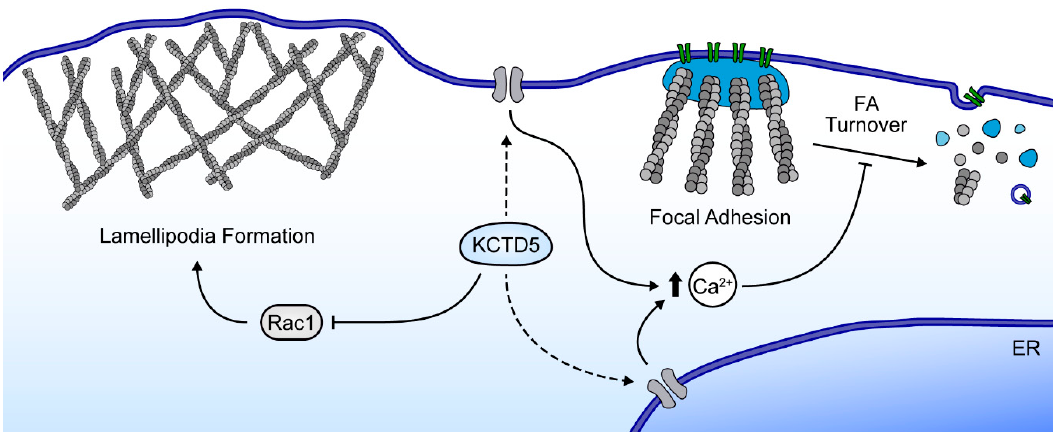
Figure 7. Proposed model. KCTD5 regulates cell migration by two paths: Ca 2+ signaling and Rac1 activity. KCTD5 promotes the serum-induced Ca 2+ entry and/or Ca 2+ release from intracellular storage, leading to a higher global Ca 2+ signal. This global Ca 2+ rise inhibits the focal adhesion turnover. On the other hand, KCTD5 inhibits the Rac1 activity, leading to a decreased lamellipodia formation. All these effects suggest that KCTD5 plays a role as a negative modulator for B16-F10 cells migration. Supplementary Materials: The following are available online at www.mdpi.com/xxx/s1, Figure S1: KCTD5 silencing enhances MCF-7 cells migration, Figure S2: KCTD5 does not affect the viability of B16-F10 cells, Figure S3: KCTD5 is not involved in Rac1 degradation, Movie S1: Serum-induced focal adhesion dynamics in shRNA Scramble -transfected B16-F10 cells. Movie S2: Serum-induced focal adhesion dynamics in shRNA KCTD5 #1-transfected B16-F10 cells.